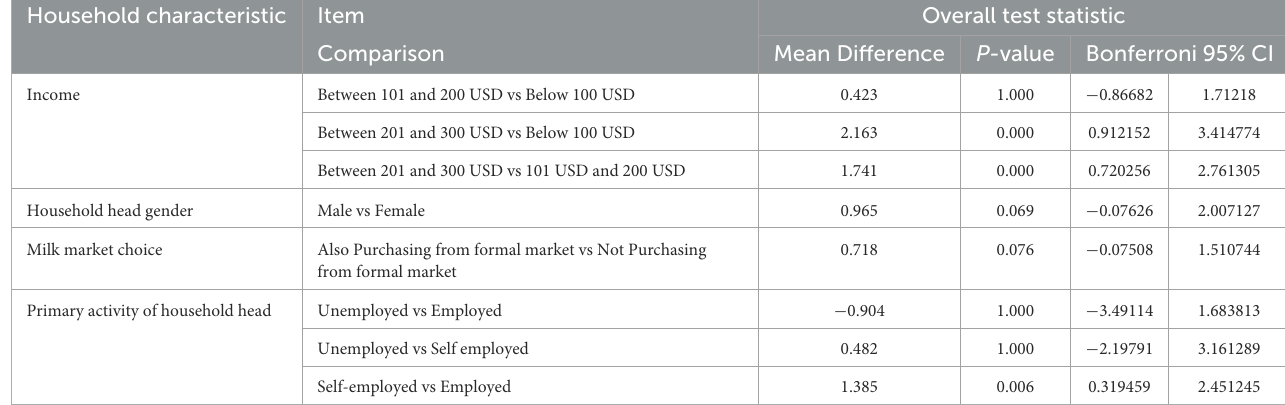
TABLE 3 Comparison of average amount of milk purchased from informal markets over 7 days across socioeconomic and demographic groups. Household